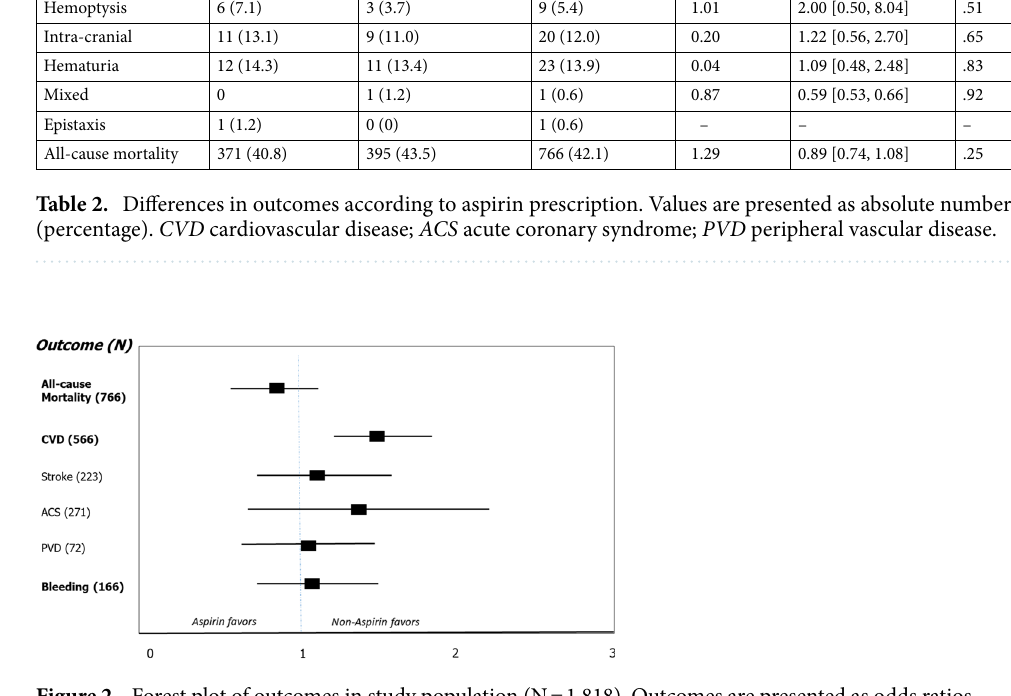
Figure 2. Forest plot of outcomes in study population (N = 1,818). Outcomes are presented as odds ratios with 95% confidence intervals. OR < 1 favors aspirin use, OR > 1 favors non using aspirin. Univariate analysis demonstrated higher incidence of cardiovascular events among aspirin users ( p <